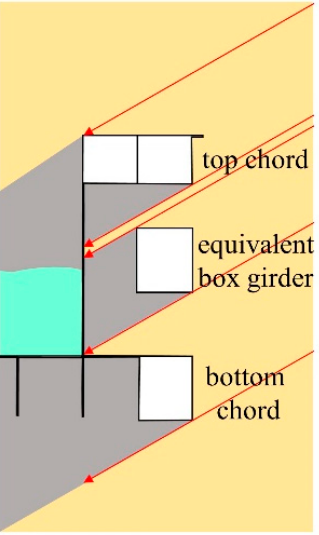
Figure 9. Illustration for local shadow effects of the equivalent box girder and top chord to the truss